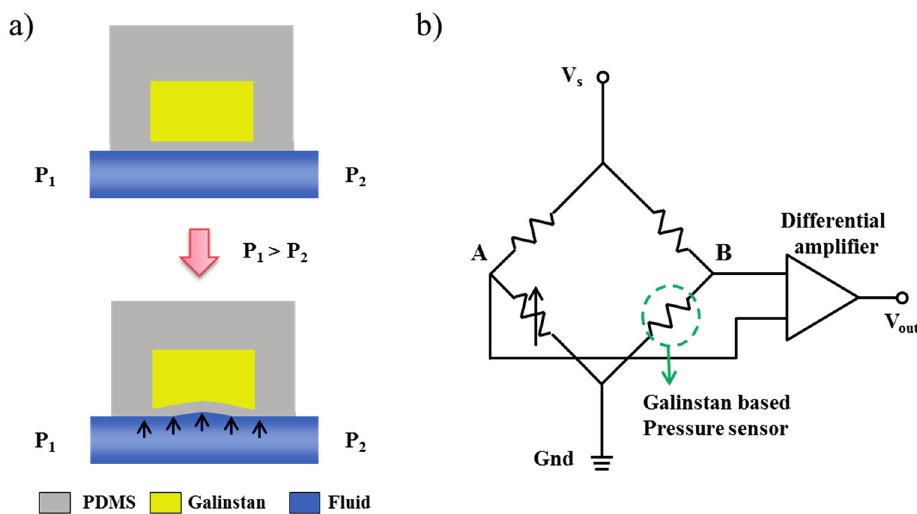
Figure 2. Working principle of a galinstan-based pressure sensor. ( a ) When the membrane is subjected to pressure, the electrical resistance of the pressure sensor gets increased due to reduction in the cross-sectional area; ( b ) Schematic of the Wheatstone bridge circuit. The pressure is estimated by measuring the voltage difference between nodes A and